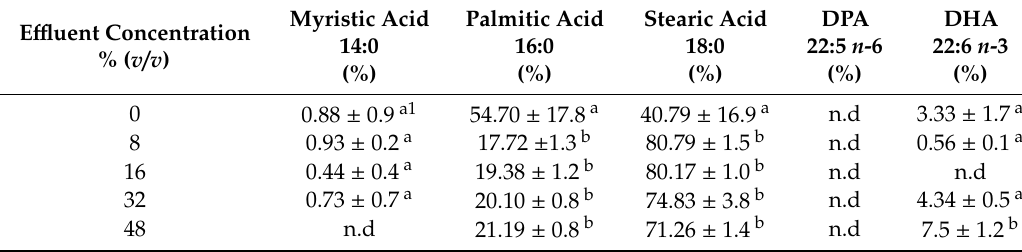
Table 2. Fatty acid (percent of total fatty acids) composition of dried algal biomass of S. limacinum grown on medium containing e ffl uent digestate at varying concentrations (0–48%) with the same carbon and nitrogen concentration without the addition of